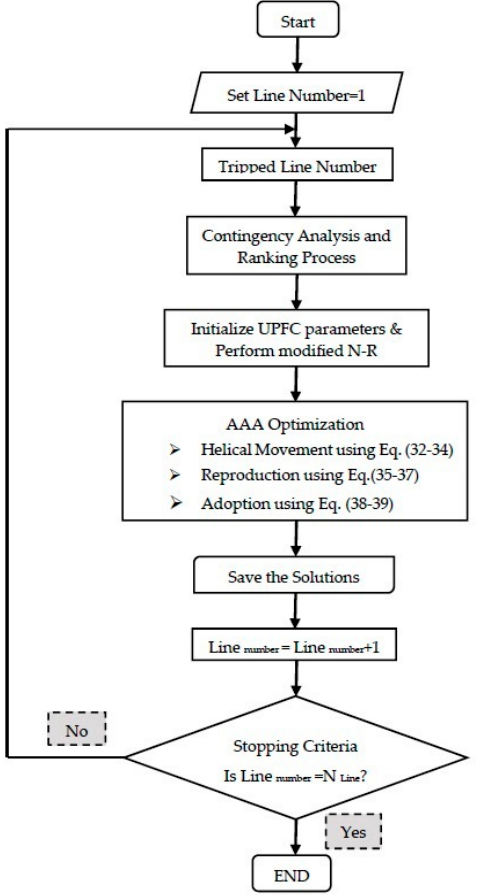
Figure 3. Flowchart AAA-Based on UPFC Location and Parameters Setting.